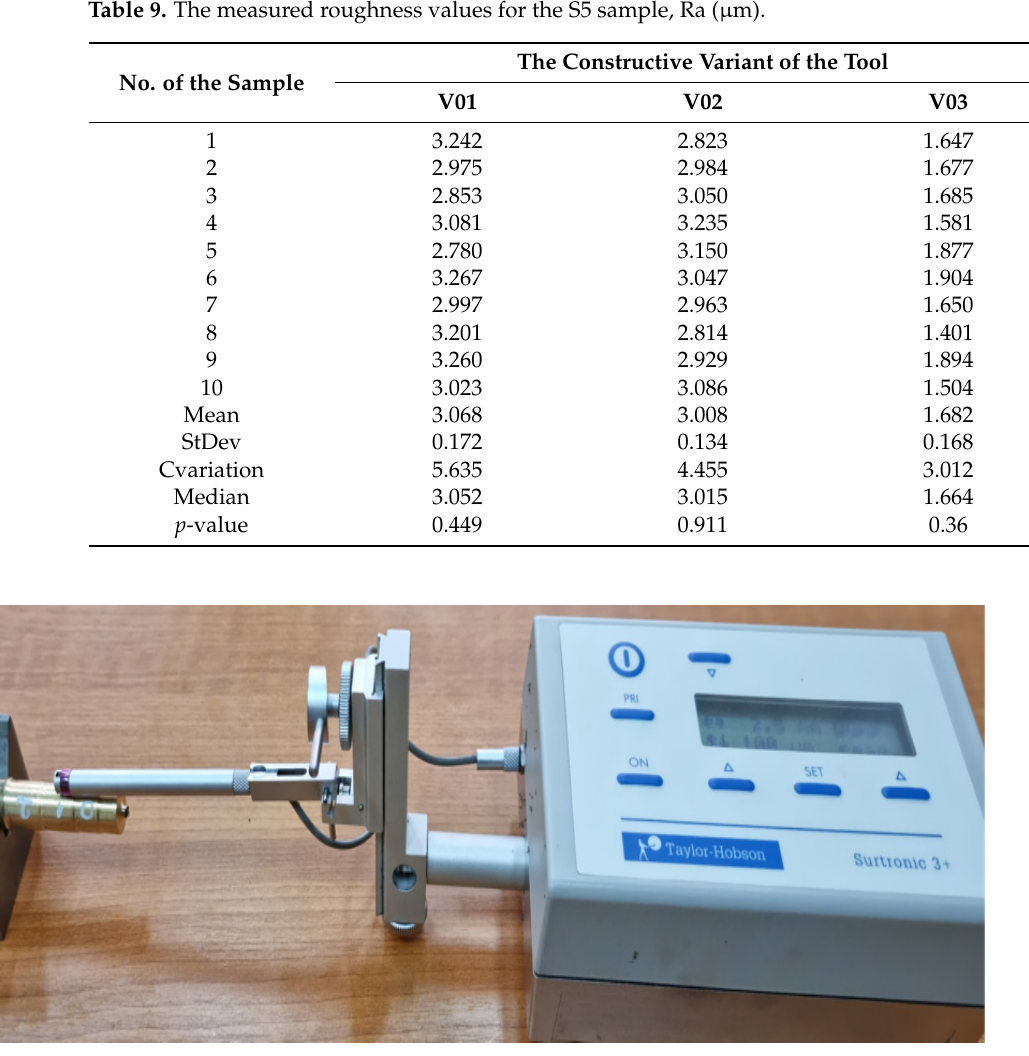
Figure 7. Images with surface roughness obtained by cutting machining. Table 9. The measured roughness values for the S5 sample, Ra (µm).